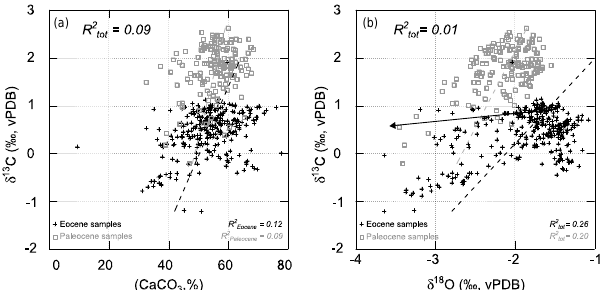
Figure 6. Plots of (a) bulk carbonate δ 13 C versus bulk oxygen δ 18 O and (b) bulk carbonate δ 13 C vs. CaCO 3 content for samples from the Cicogna section. The black arrow shows the expected effect of burial diagenesis. Grey and black dash lines are linear trend lines for Paleocene and Eocene samples, respectively. Note the clear dis- tinction in δ 13 C for Paleocene and Eocene samples, which relates to a long-term decrease in δ 13 C (Fig.